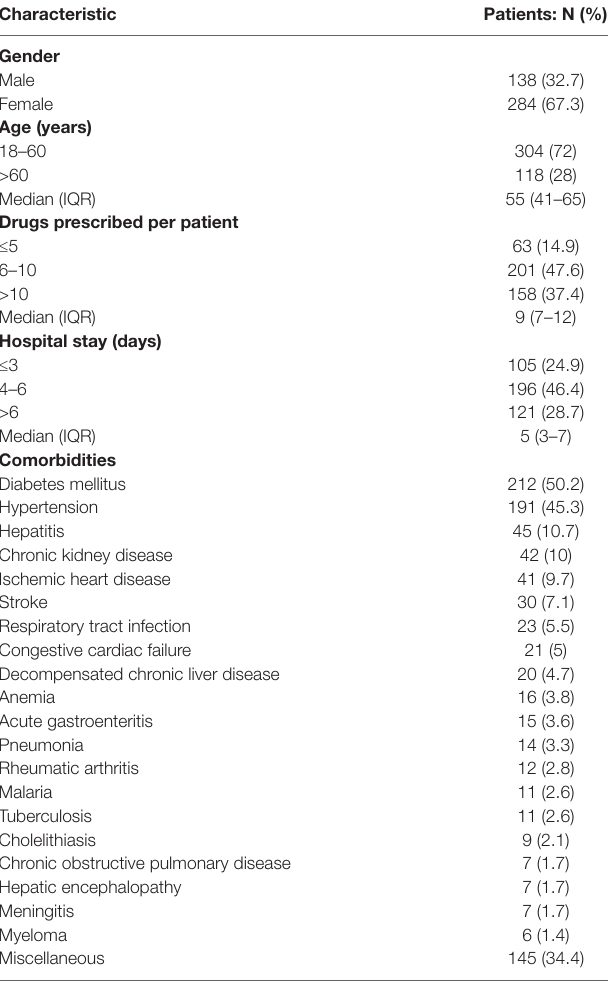
TABLE 1 | General characteristics of study subjects ( n = 422). Characteristic Patients: N